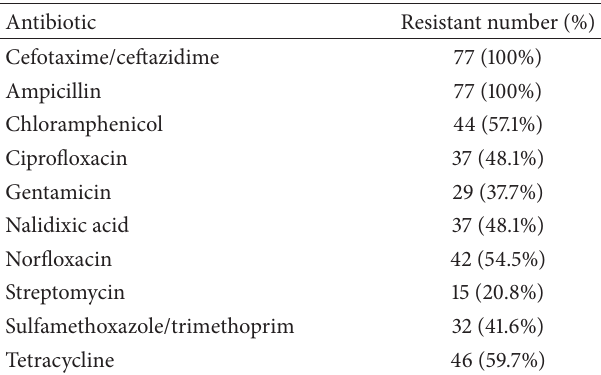
Table 2: Antibiotic susceptibilities of the isolates 𝑛 = 77